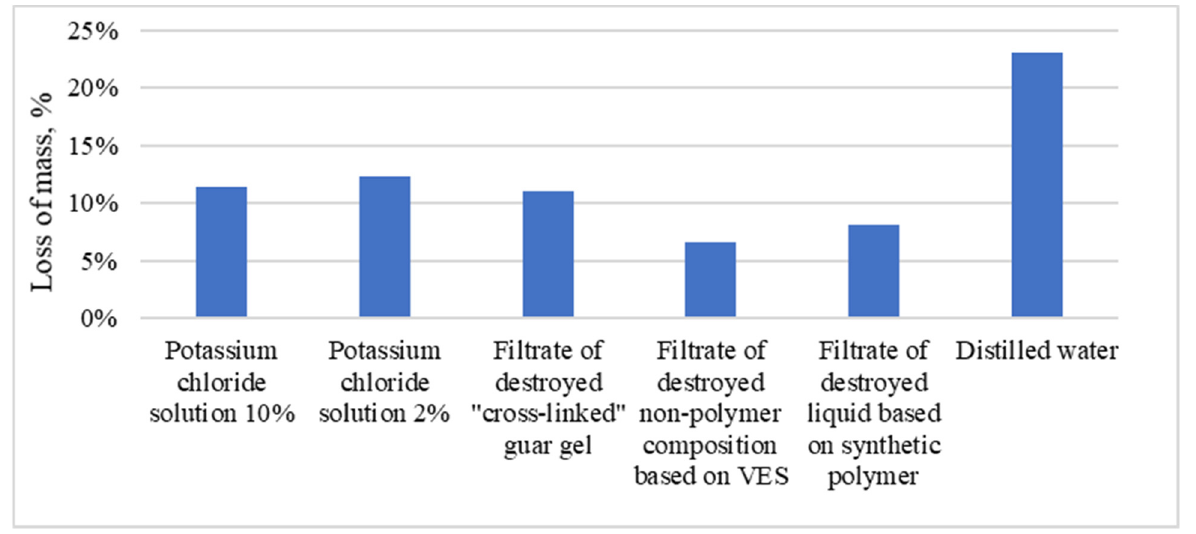
Figure 9. Results of the disintegration test by hot rolling.